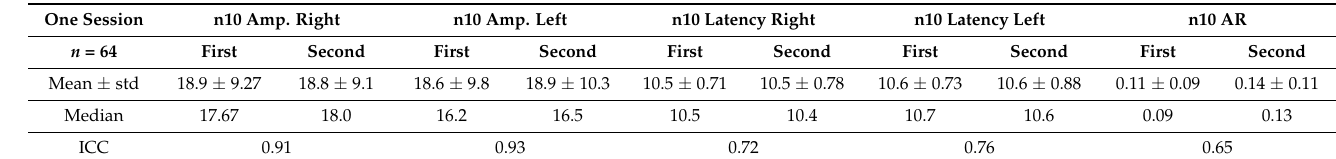
Figure 5. Phase synchronization vector (PSV) and delta shift-vector (DSV) of n10 amplitude from 92 volunteers; ( a ) the PSV of the left side (right measured); ( b ) the PSV of the right side (left measured); ( c ) the PSV from left and right side; and ( d ) the DSV (difference: right PSV—left PSV). The unit of amplitude is µV and the unit of the latencies with LSD is ms. The parameters AR, PSV, and DSV are normalized and dimensionless. Table 3. Calculated amplitudes and latencies (side-specific) of the n10 wave and asymmetric ratio with mean ± standard derivation (std), median, and interclass correlation coefficient (ICC) depending on first and second measurements in one session.